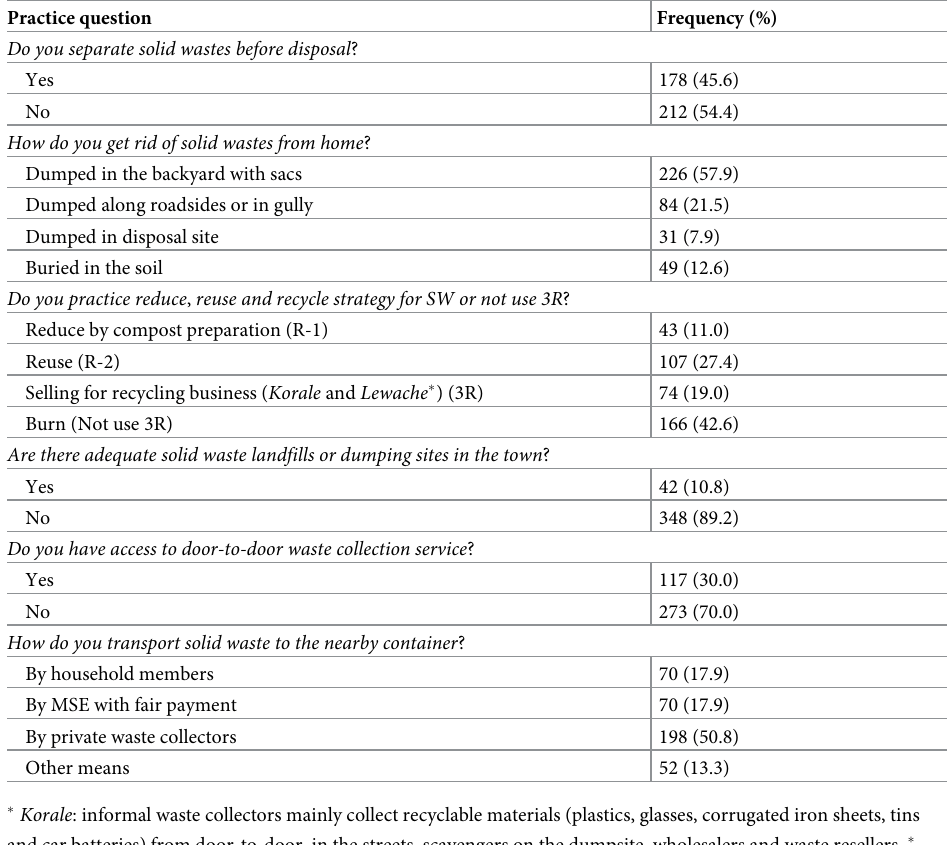
Table 4. Households’ practices on